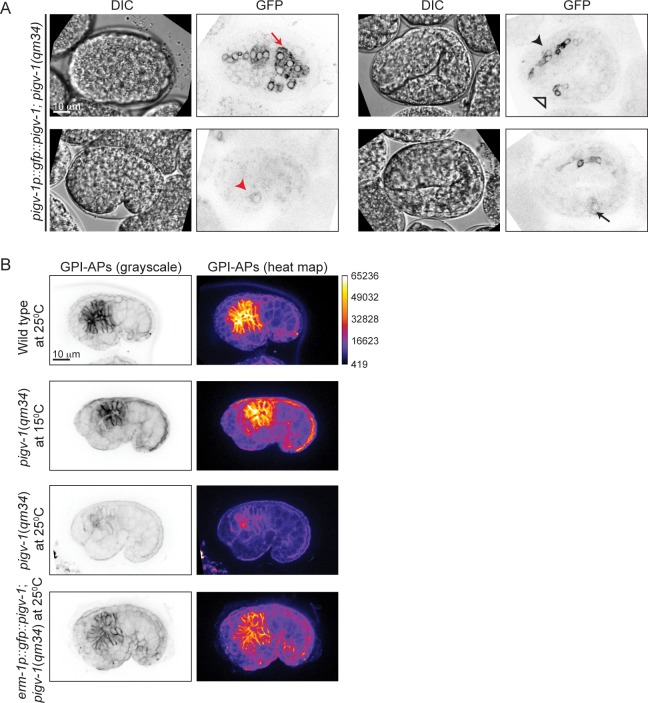
PIGV-1 is expressed in all embryonic epithelial tissues where it is essential for GPI-anchor biosynthesis.(A) PIGV-1 is expressed in epithelial tissues during embryogenesis: epidermis (top left panel); excretory cell (bottom left panel); pharynx, and rectum (top right panel) and intestine (bottom right panel). In this and subsequent images, red arrow indicates epidermis, black arrow indicates intestine, black arrowhead indicates pharynx and red arrowhead indicates excretory canal and open arrowhead indicates rectum. (B) FLAER staining highlights GPI-APs localization at the membrane of embryonic tissues in wild type and mutant embryos at comma stage. Differences in FLAER staining intensity are demonstrated by heat maps of corresponding images (right panels). Similar fluorescence intensity is observed in wild type and pigv-1(qm34) embryos grown at the permissive temperature, but highly reduced in pigv-1(qm34) embryos grown at the restrictive temperature. Expressing PIGV-1 in pigv-1(qm34) restores GPI-AP biosynthesis and their localization at restrictive temperature.